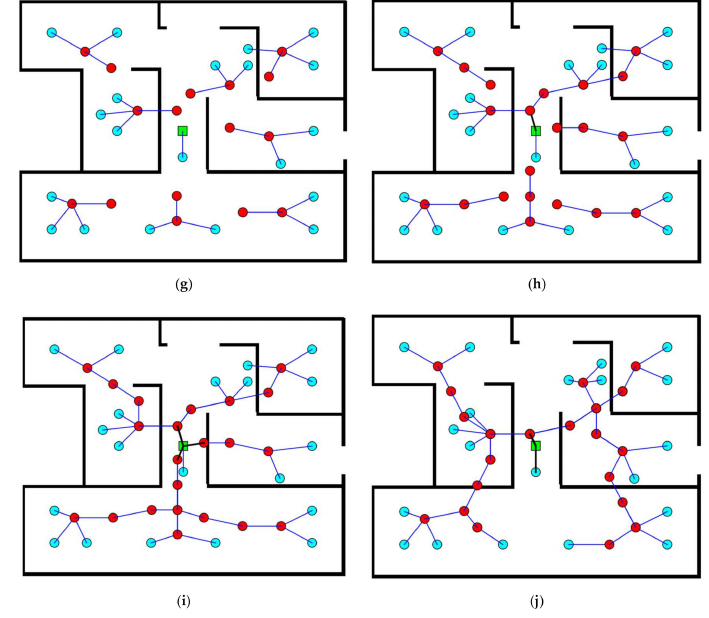
Figure 2. Illustrative example: ( a ) Initial layout; ( b ) Connection of an end device (ED) to the base station (BS); ( c ) grid construction over the entire floor plan; ( d ) routers list filtering; ( e ) best router proposal for a given ED; ( f ) connection of all EDs to routers; ( g ) connection of the first set of routers to a second set; ( h ) connection of the second set of routers to a third set; ( i ) final design; and ( j ) an alternative final